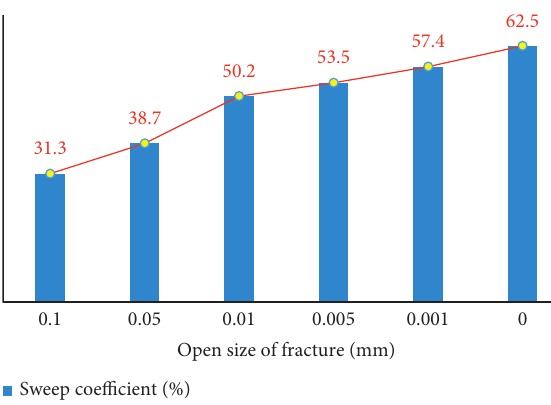
Figure 11: Water flooding sweep coefficients of fractured reservoirs with variable opening